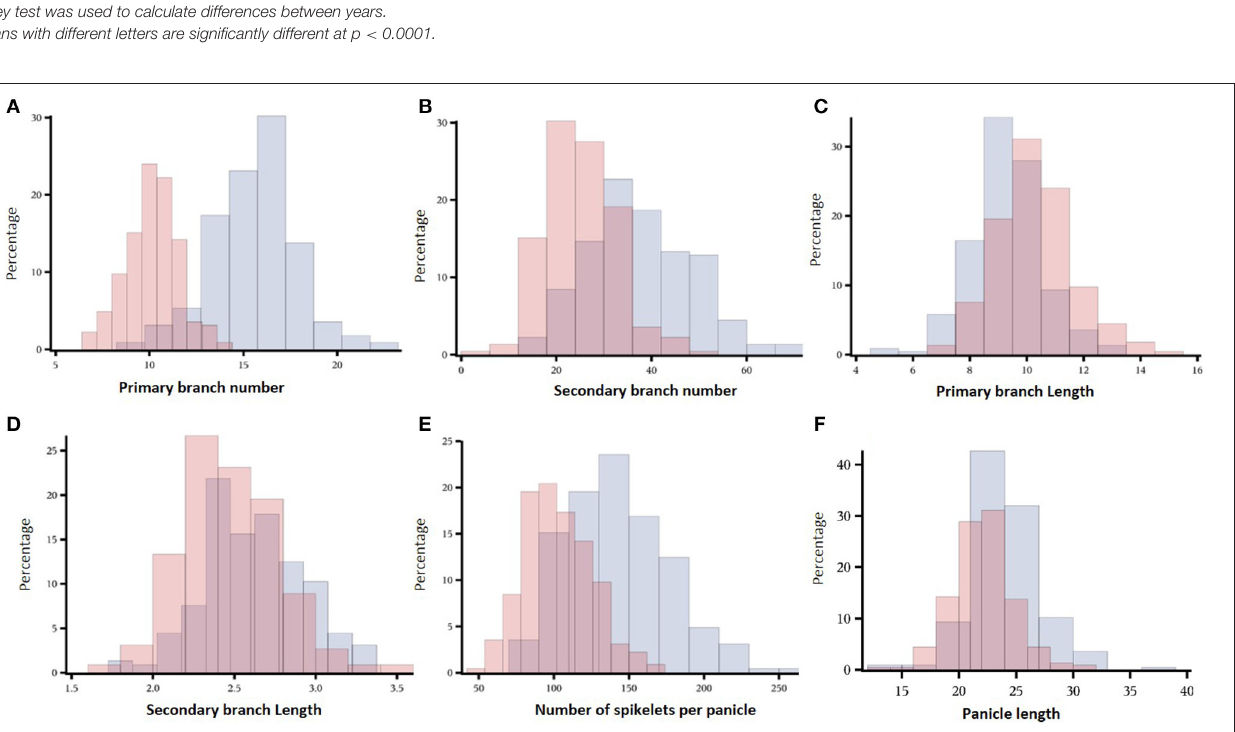
panicle architecture variables only in the cases of SBN in Exp2- DRS (q-9) and PBN in Exp1-TR (q-43) ( Figure 3 ). No collocation was observed between NSP and PBL or SBL within the same experiment. Finally, no GWAS collocations occurred between the number of branches (SBN, PBN) and the length of branches (SBL, PBL) ( Figure 3